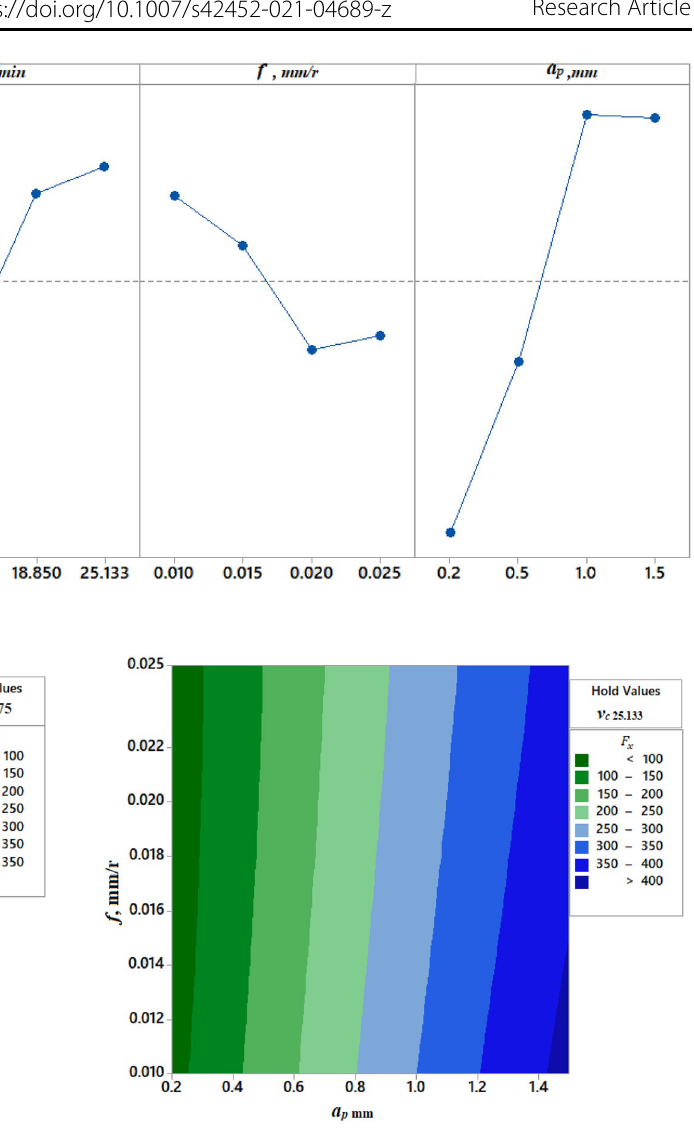
Fig. 13 Cutting force F x vs f , and a